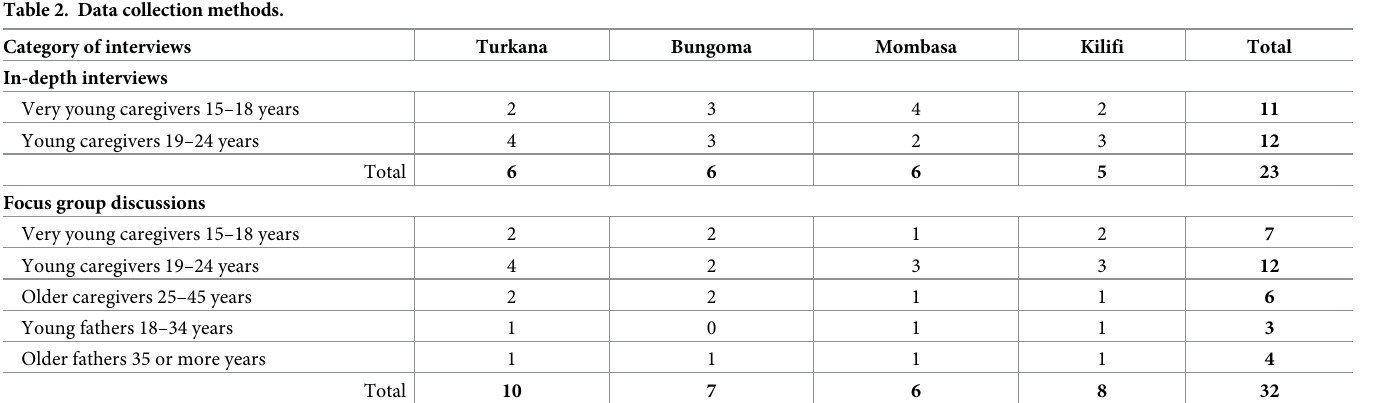
Table 2. Data collection